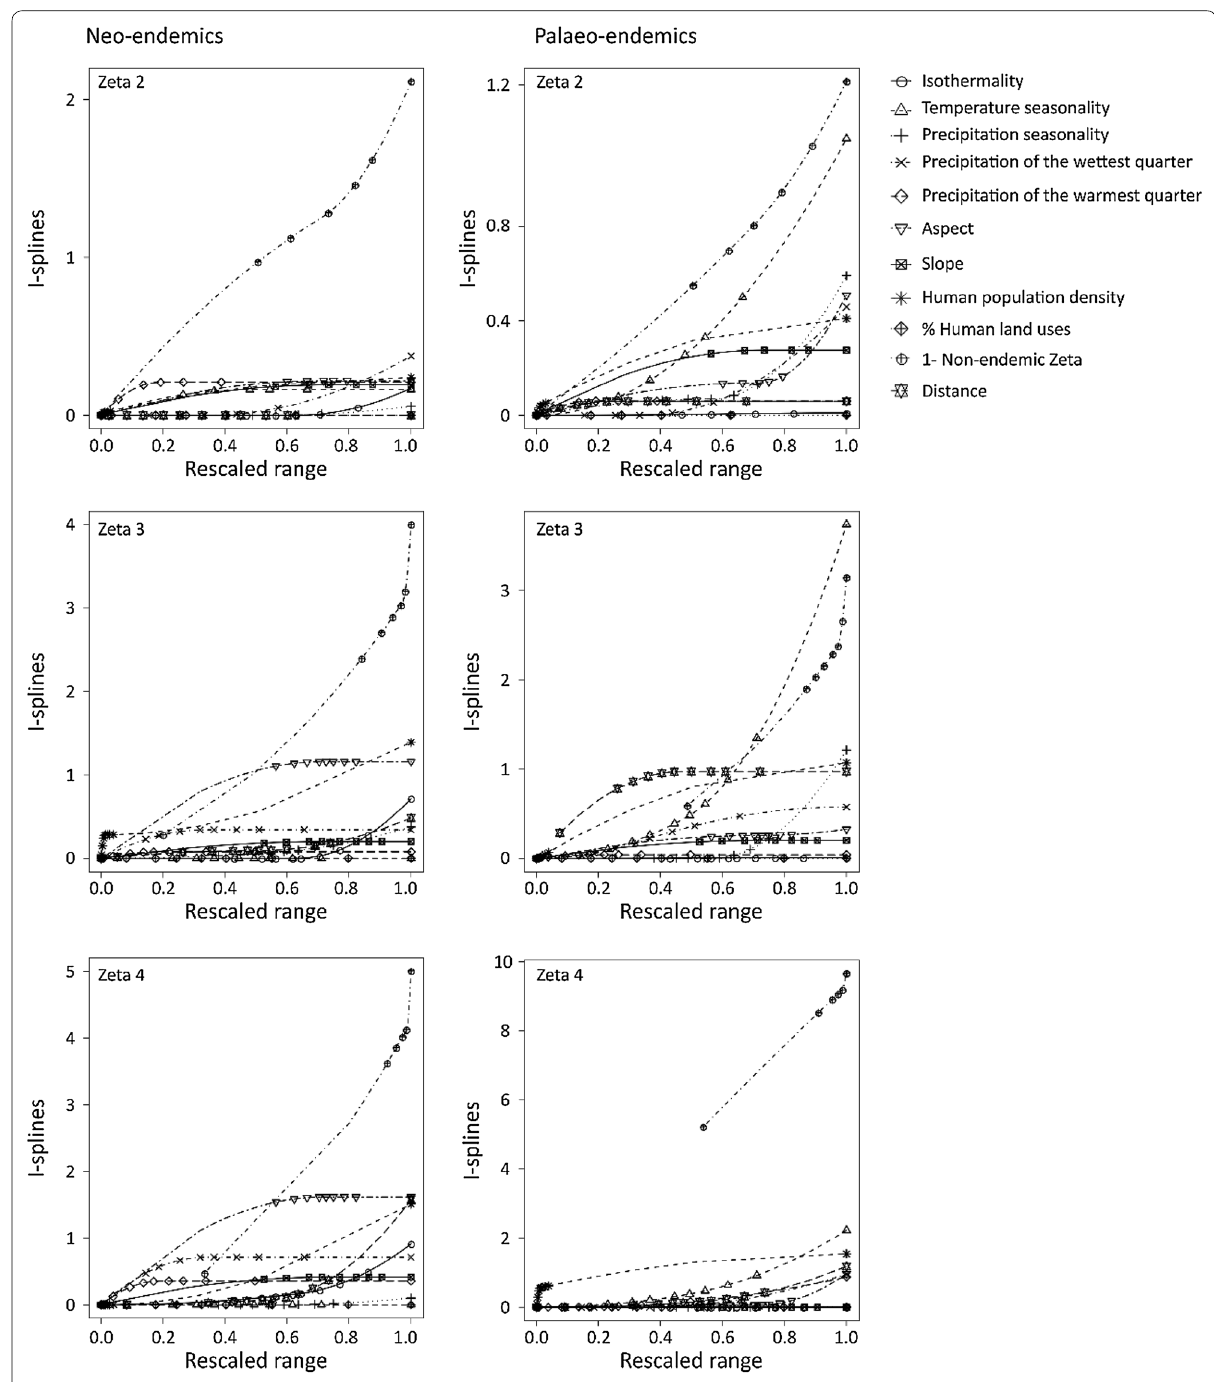
Fig. 4 The effects of non‑endemic zeta diversity, environmental variables and distance on differences in zeta diversity for different zeta orders estimated by Simpson index for neo‑endemic and palaeo‑endemic vascular plants of Crete, Greece, as were estimated by multi‑site generalized dissimilarity biotic model I. The predictors were transformed with